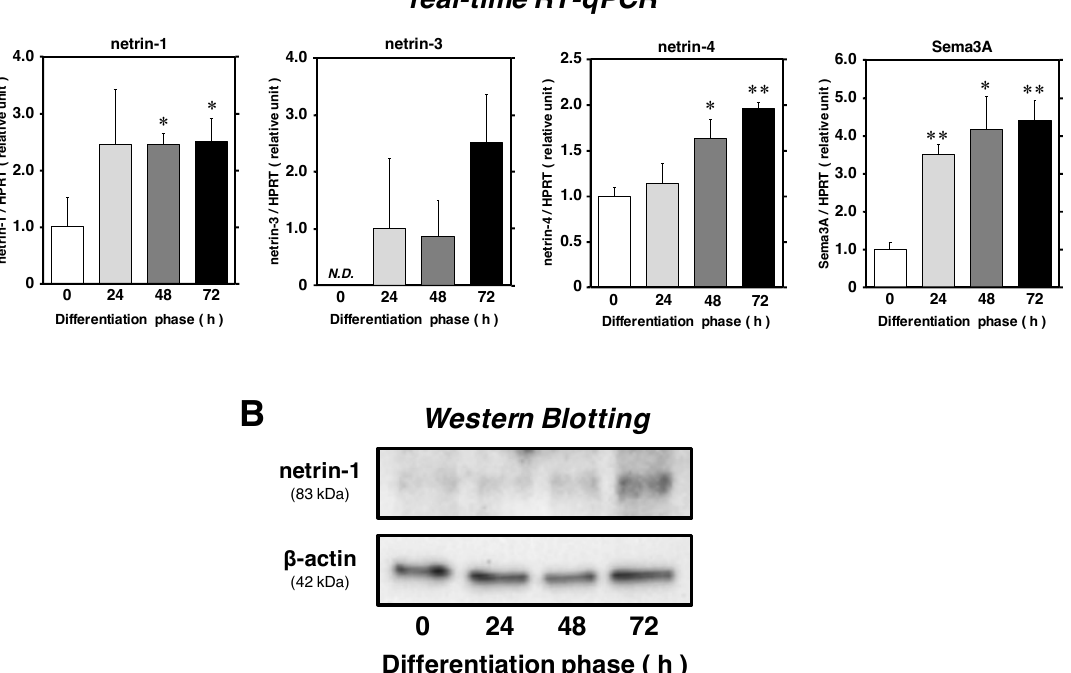
Figure 2. The expression levels of netrins were upregulated in satellite cells during myogenic differentiation. Satellite cell primary cultures, prepared as shown in Figure 1, were maintained in differentiation medium (DM) after the induction of proliferation. (panel A ) The mRNA expression of netrin-1, -3, and -4 and Sema3A was evaluated by real-time RT-qPCR normalized to the level of HPRT at all time points indicated. The bars depict the mean ± SEM of three independent cultures by relative units, as compared to differentiation at 0 h. As netrin-3 expression could not be detected at 0 h, relative units were compared to the 24 h time point. Significant differences from the mean of 0 h (the left-most open bar) at p < 0.05 and p < 0.01 are indicated by single and double asterisks, respectively. (panel B ) The protein expression of netrin-1 was detected with ECL-Western Blotting standardized to β -actin expression